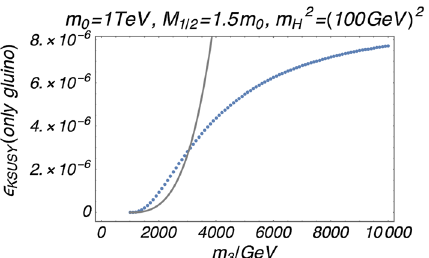
Fig. 7 The plot of the gluino contribution to (cid:5) K for a function of m 3 . The blue dotted line shows the numerical result by the only susy_flavor . The gray line denotes the result by the mass inser- tion approximation in Eq.(A1). Note that all calculations include only so-called V LL element[99]tocomparewiththemassinsertionapprox-